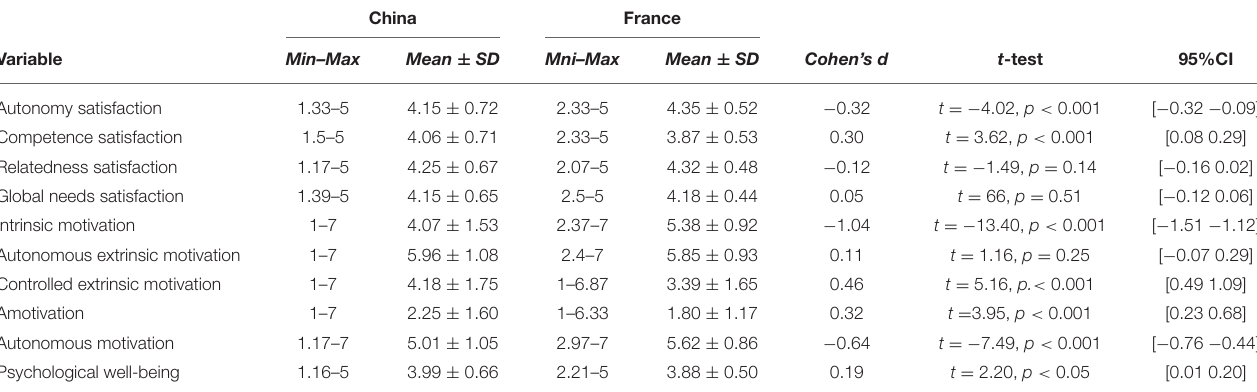
TABLE 1 | Means and standard deviations of observed constructs in the Chinese and French sample. China